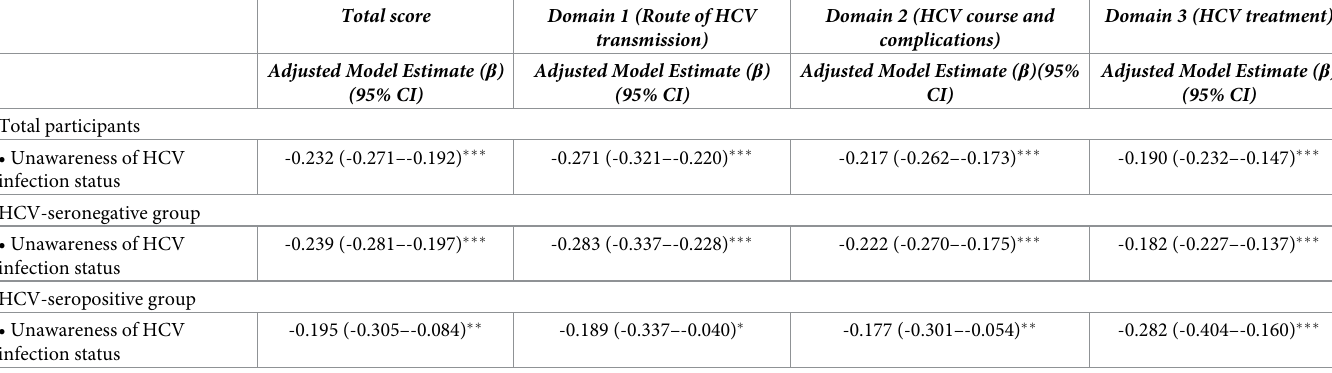
Table 4. Association of UoHCV with HCV knowledge scores, stratified by knowledge domain in a multivariable linear regression †